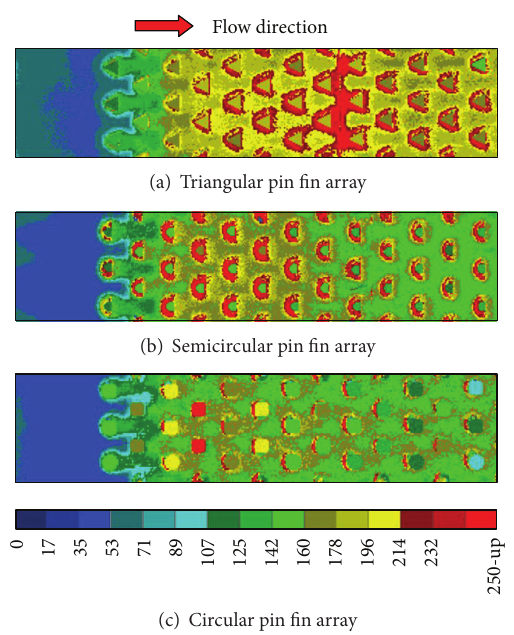
Figure 7: Dimensional heat transfer coefficient distributions in W/m 2 K units for the configurations shown in Figure 6 from Siw et al.